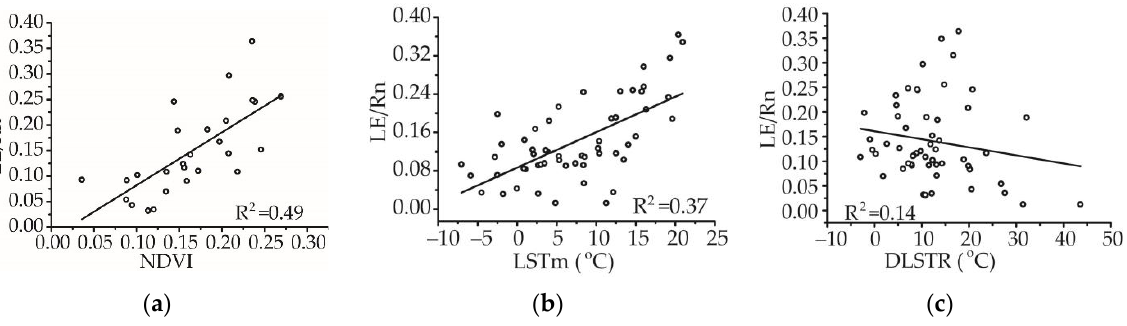
Figure 3. Correlation analysis of the ET to Rn ratio (ET/Rn) and normalized difference vegetation index (NDVI) ( a ), mean land surface temperature (LSTm) ( b ), and the range of LST difference (DLSTR) ( c ).